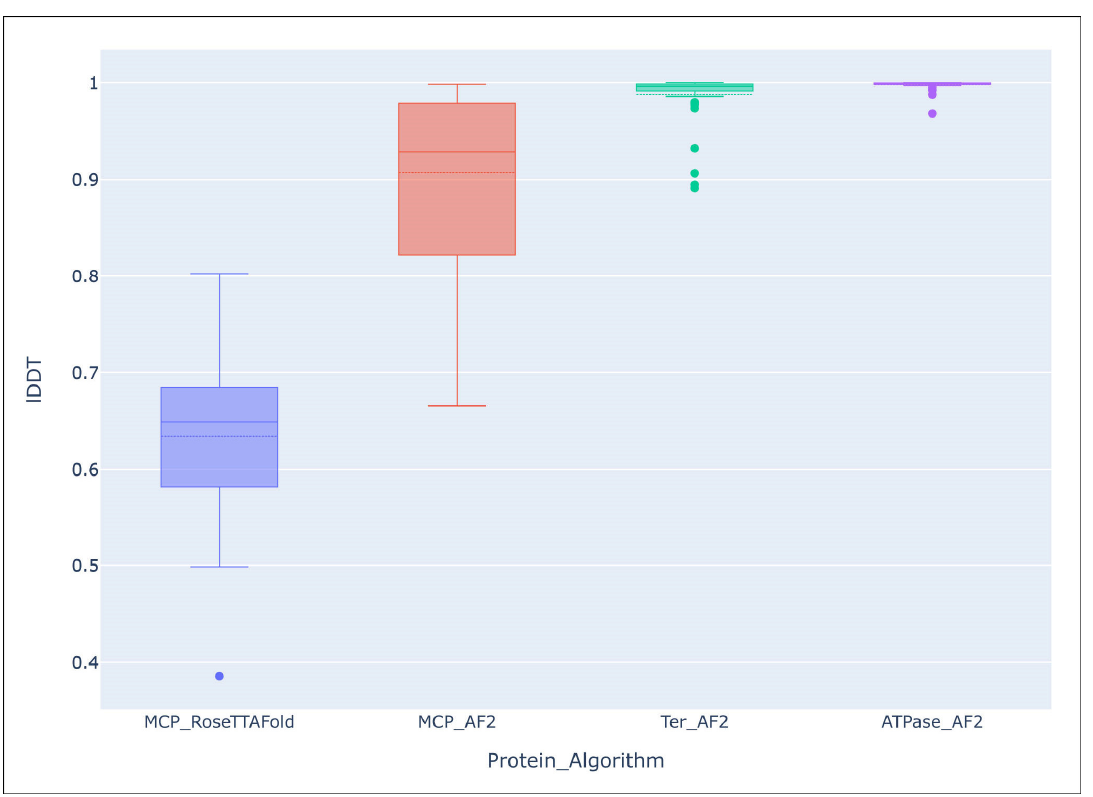
Figure 6. Comparison of the overall accuracy of predictions made with the Local Distance Difference Test (lDDT), using the DeepAccNet accuracy predictor. MCP_RoseTTAFlold–RoseTTAFlold models of the MCP, MCP_AF2–AlphaFold models of the MCP, Ter_AF2–terminase ATPase subunits’ models predicted with AlphaFold, ATPase_AF2–ATPase domain of terminase ATPase subunits’ models predicted with AlphaFold.